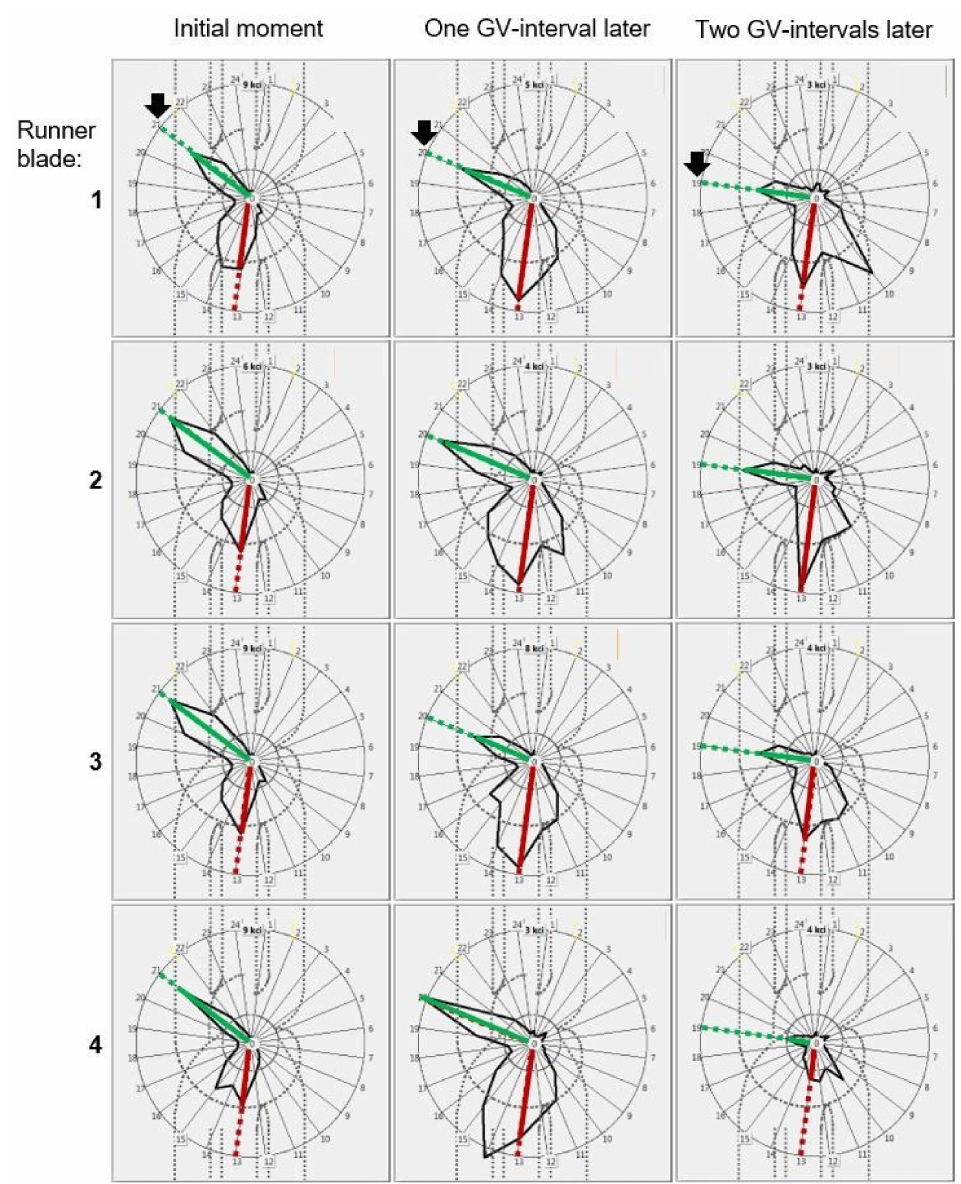
Figure 15. The patterns of the instantaneous cavitation intensity I (